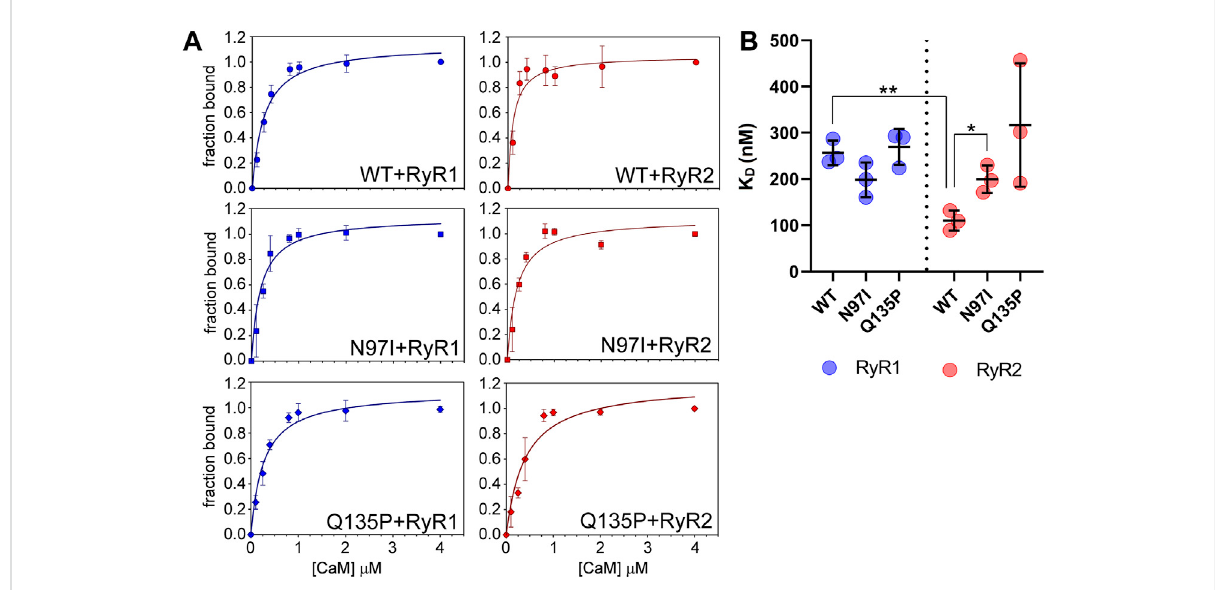
FIGURE 4 CaMaf fi nityfor RyR1and RyR2peptides assessed by fl uorescencespectroscopy. (A) OnemicromolarRyR1(leftcolumn)orRyR2(right column) peptide was incubated with increasing amounts of WT (top row), N97I (middle row) and Q135P (bottom row) CaM in the presence of 100 µM Ca 2+ . Data are reported as a function of the peptide fraction bound to CaM (see Materials and Methods for details). Curves report the mean ± std of each point obtained in three technical replicas. Representative fi tting to one-site saturation ligand binding curve is superposed to each titration set. (B) ScatterplotofreplicatesreportingtheK